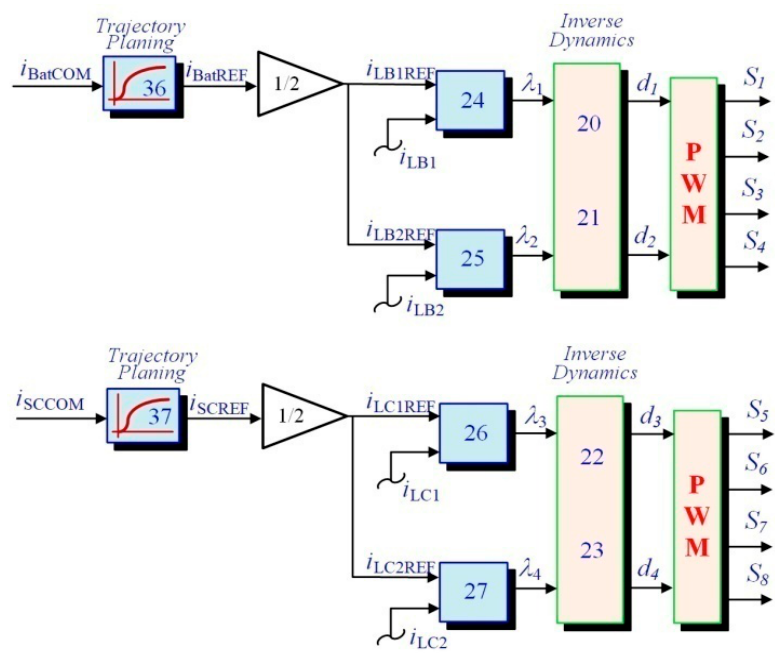
Figure 3. Proposed inner current regulation loops based on the differential flatness approach.